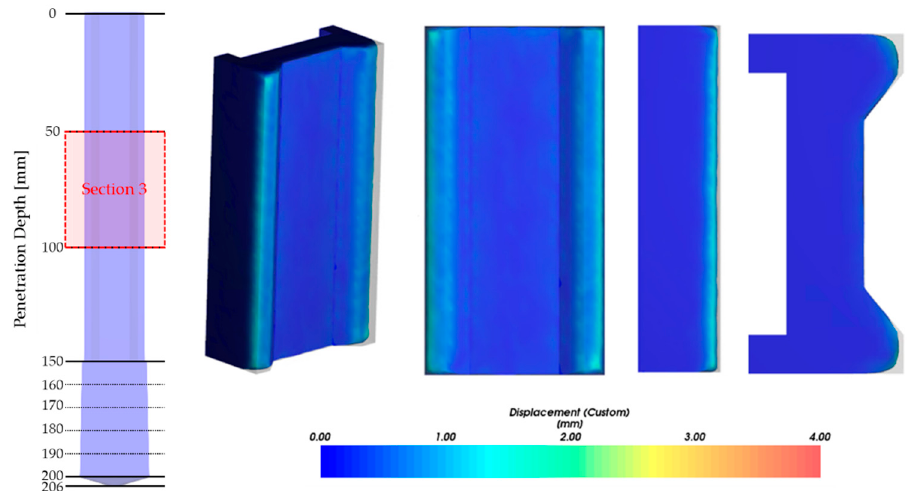
Figure 14. Worn displacement on Section 4.